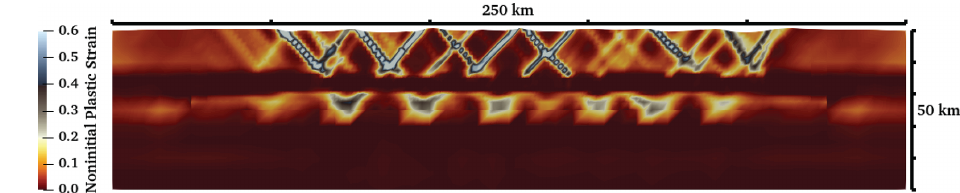
Figure B2. Cross section at y = 375km, showing the non-initial plastic strain attribute through 10Myr of the model run. This location corresponds to the boundary between the weak and reference (north) domains. See Fig. 4b for a 10Myr snapshot. Screenshot taken at 10Myr.